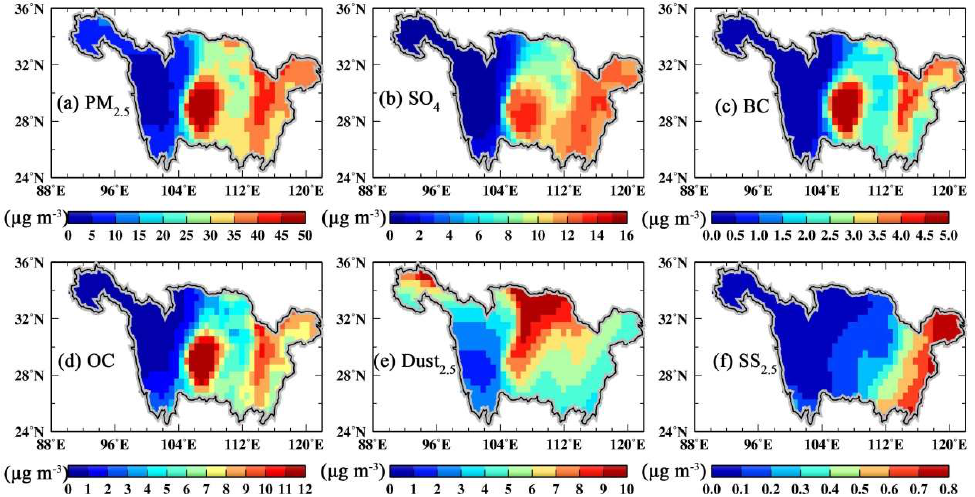
Figure 6. Annual mean distributions of each MERRA-2 PM 2.5 component, including ( a ) the PM 2.5 , ( b ) Sulfate PM 2.5 , ( c ) Black Carbon PM 2.5 , ( d ) Organic Carbon PM 2.5 , ( e ) Dust PM 2.5 and ( f ) Sea Salt PM 2.5 over the YRB during